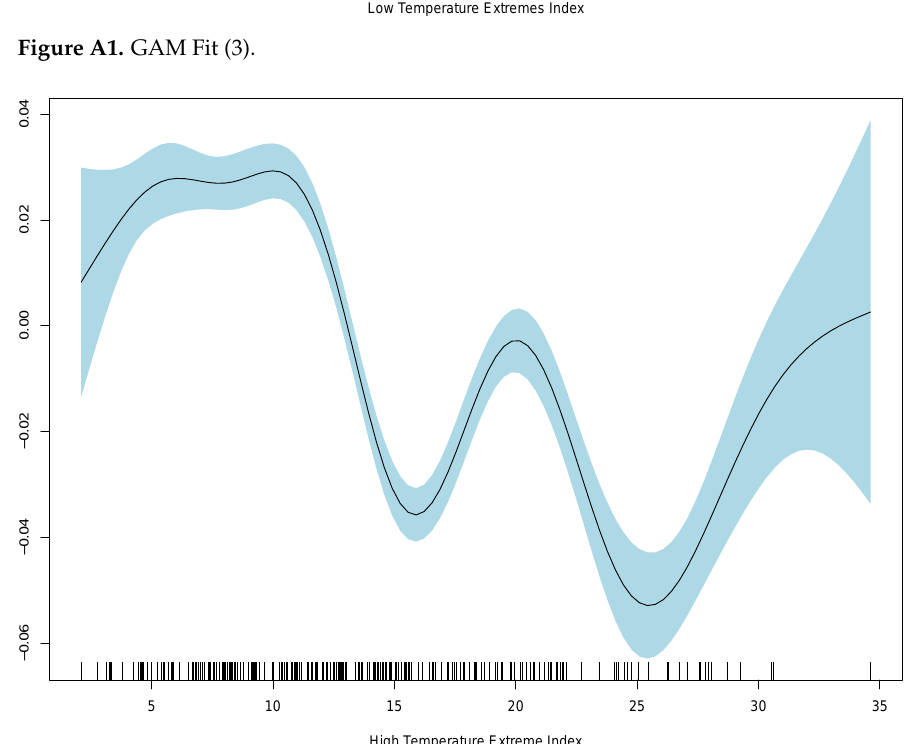
Figure A2. GAM Fit